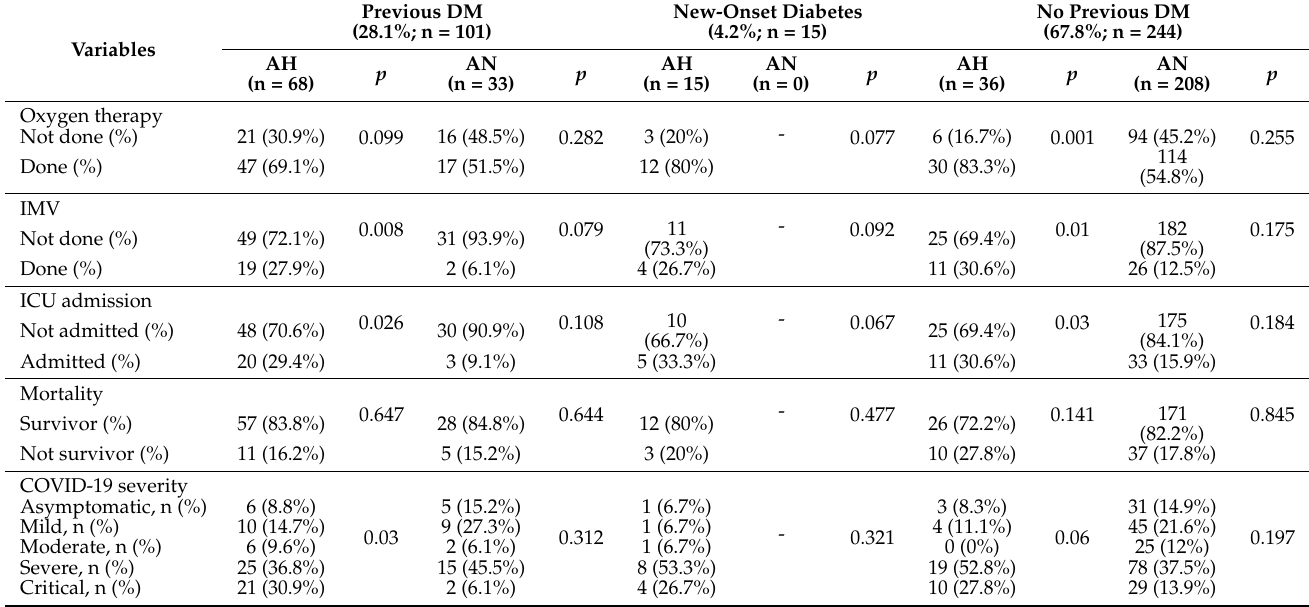
Table 5. Clinical outcomes considering the glycemic status and diabetes